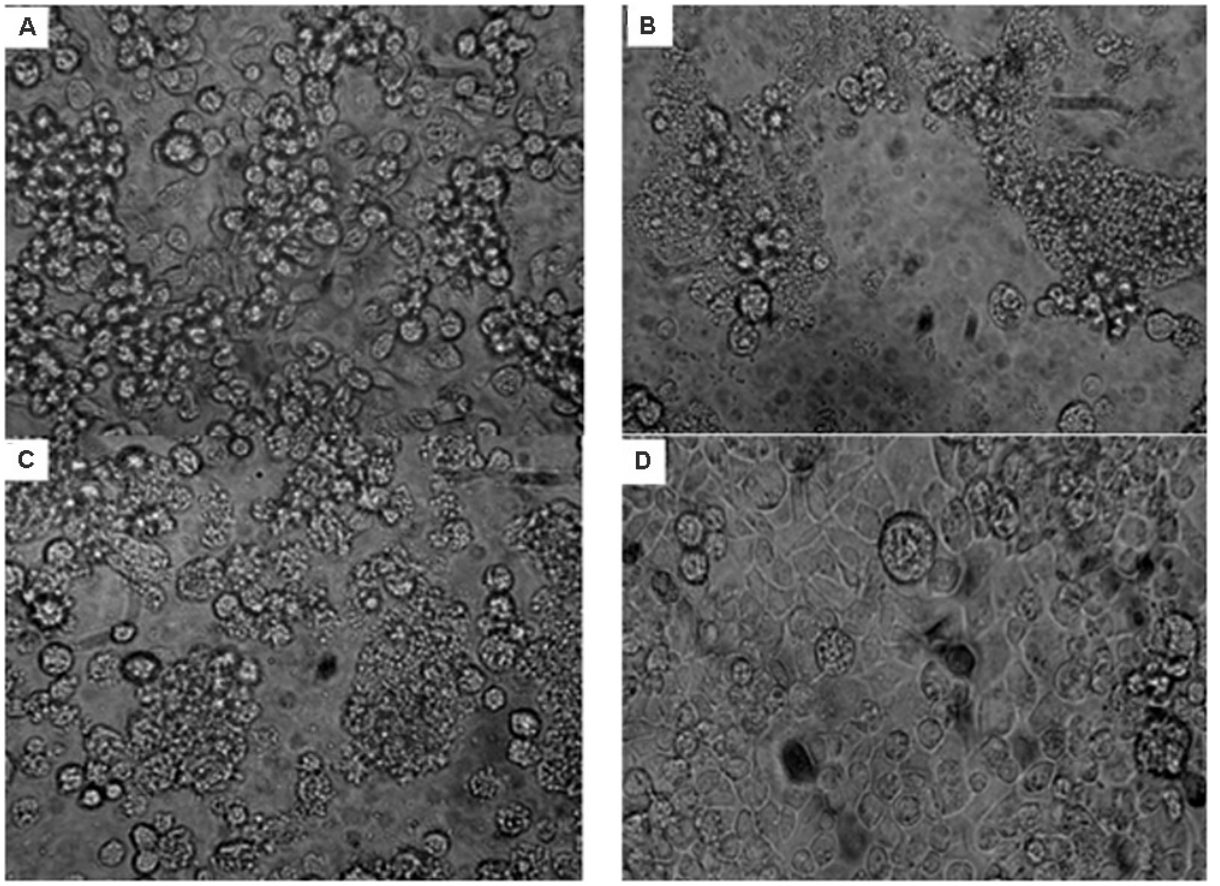
Figure 4. Inverted microscopic photographs of the cytopathic effects of dengue virus on C Aedes 6/36 albopictus infected cell cultures. ( A ) Uninfected control C cell cultures, with normal cellular morphology. 6/36 ( B ) Cell cultures infected with DENV-2 (3.5 x 10 5 PFU), showing advanced infection stage with large cell mass disrupted over seven days of infection. ( C ) Cells cultures infected with DENV-2 and treated with quercetin (500 µg/mL) with low cell damage over seven days of infection. ( D ) Cells cultures infected with DENV-2 treated with rutin (500 µg/mL) over seven days of infection, showing only an initial disorganization in groups of infected